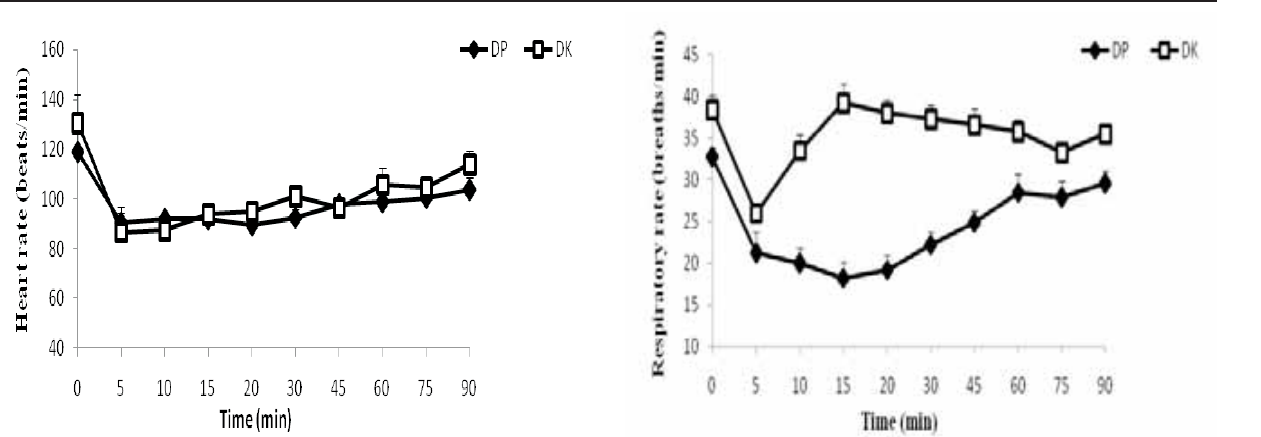
Figure-6: Mean±SE values of respiratory rate in the animals of groups DP and DK at different time intervals.